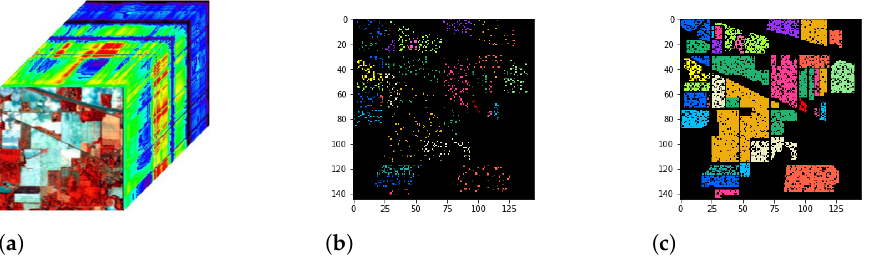
Figure 1. ( a ) The HSI data cube of Indian Pines dataset [21], ( b , c ) illustrate the training set and the testing set under the random sampling strategy in HSI classification. The colored points represent the selected pixels. The training set consists of samples randomly selected with a fixed number in each categories, and the remaining samples form the testing